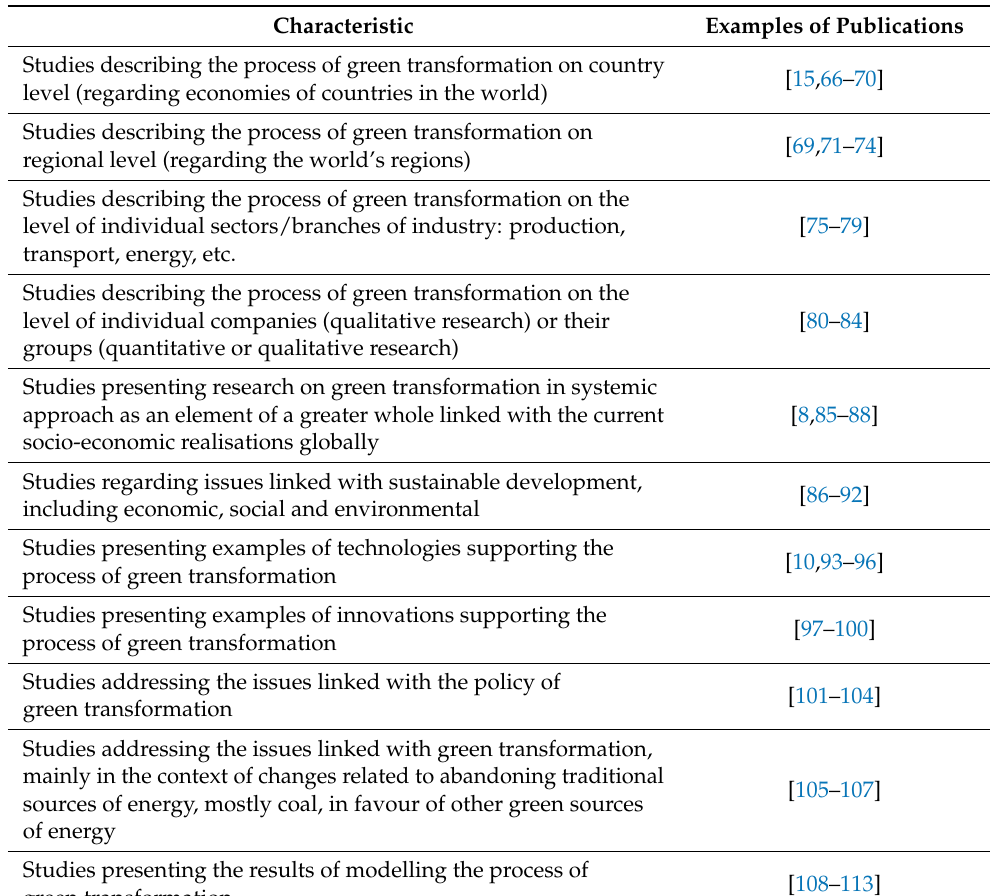
Characteristics typical of research on green transformation (or transition) in the analysed